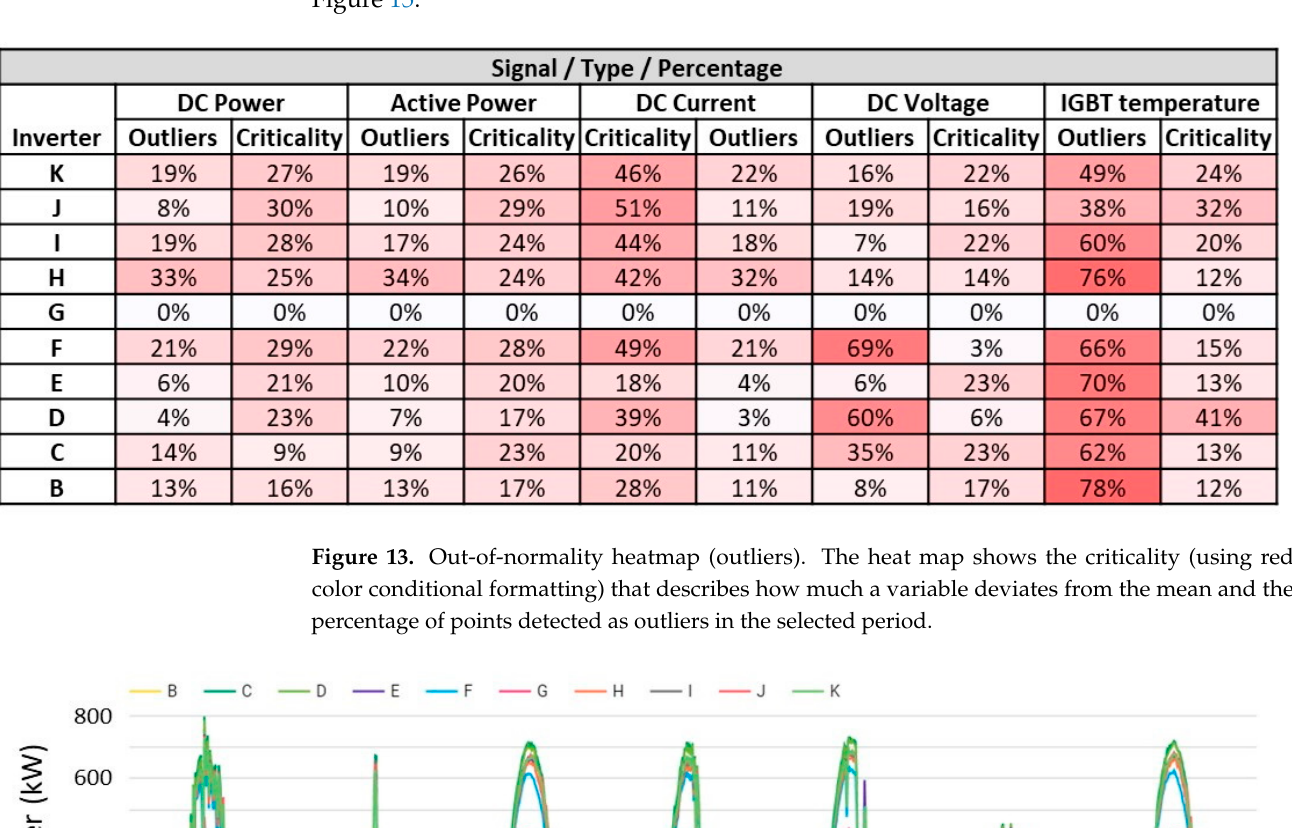
Figure 14. Signal comparison between inverters B–K (depicted by different colors) during the first week of January 2021.